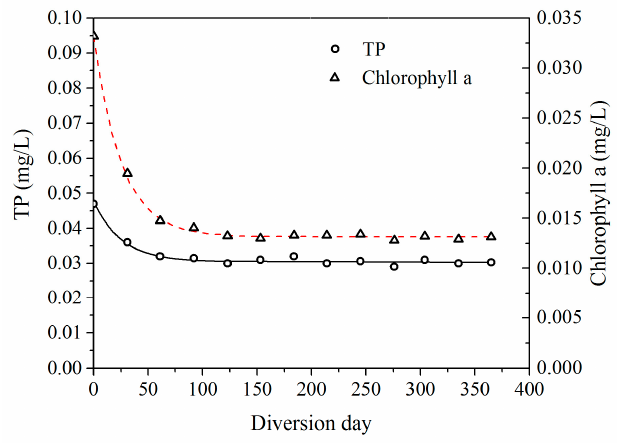
Figure 9. Downward trend of TP and chlorophyll a in Beili Lake after the diversion.